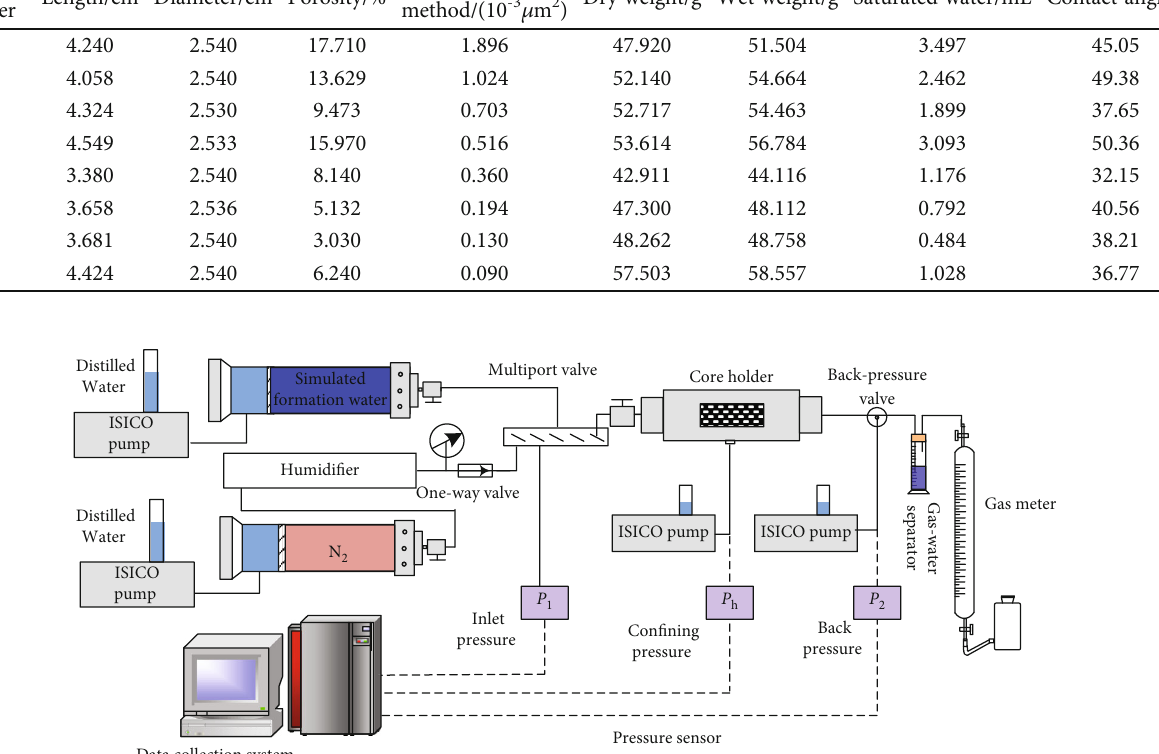
Figure 1: Flow chart of gas – water phase permeability test by the improved steady-state